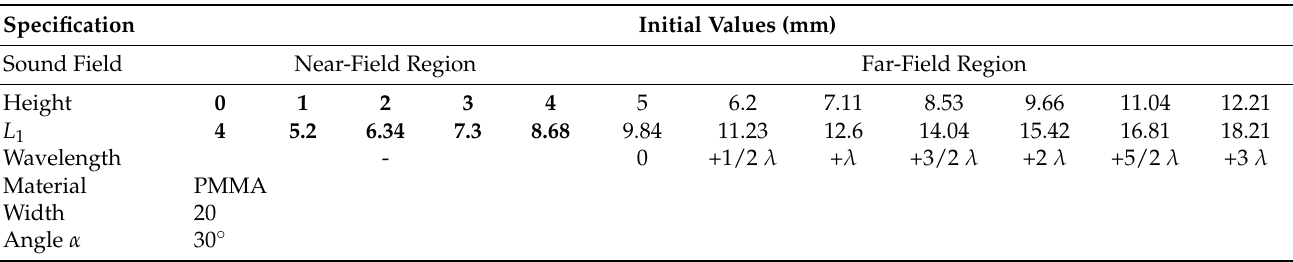
Table 3. Wedge block parameters and initial